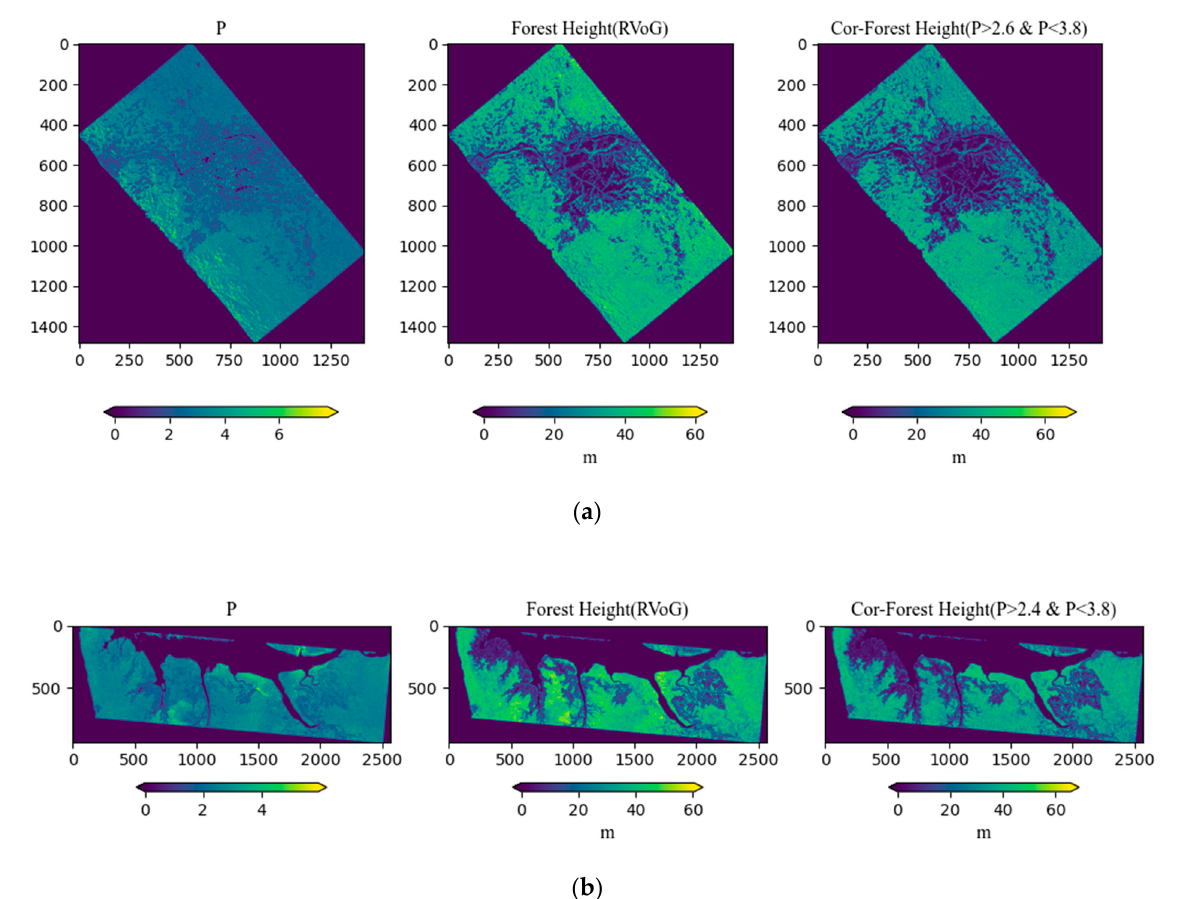
Figure 15. Correction results based on P RF in the lope test area ( a ) and the Pongara test area ( b ).